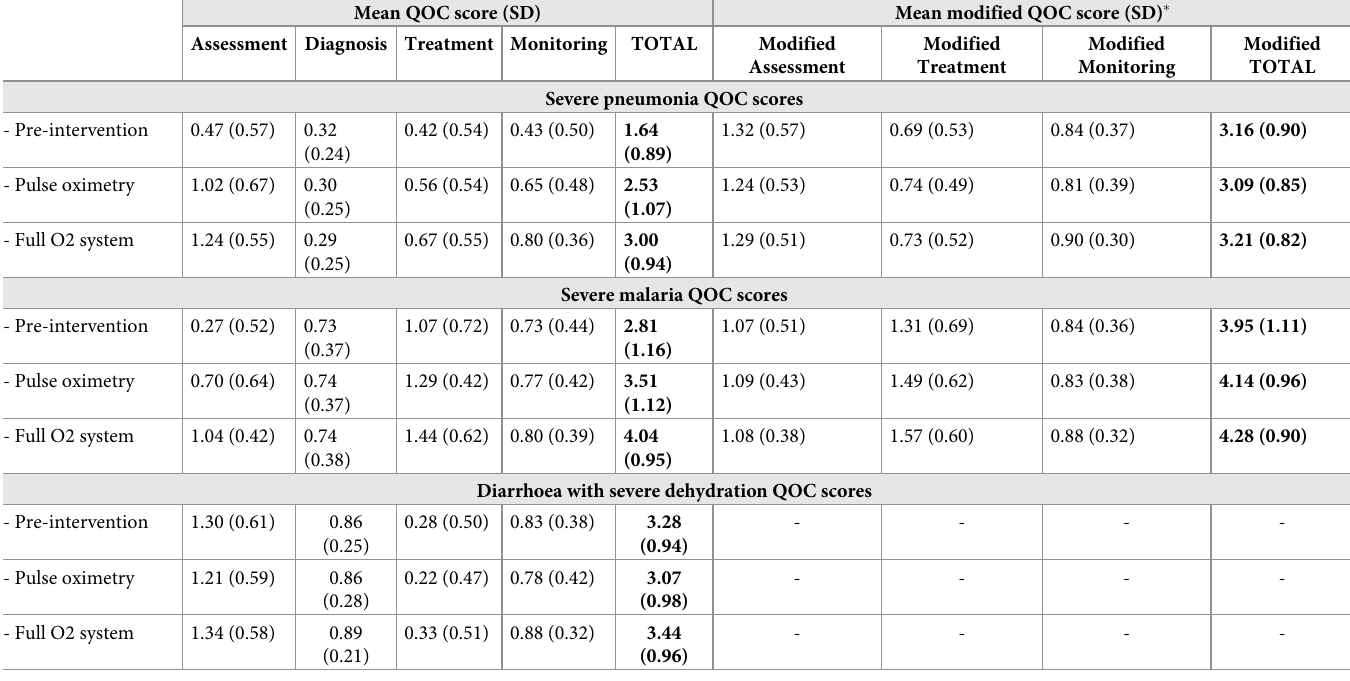
Table 2. Mean QOC scores for children with severe pneumonia, malaria, and diarrhoea, showing crude changes over time and by score component (assessment, diagnosis, treatment,